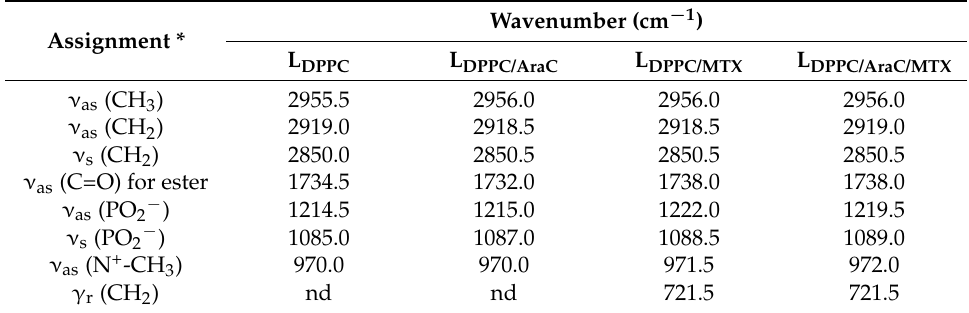
Table 2. Assigned bands of the FT-IR spectra of L DPPC , L DPPC/AraC , L DPPC/MTX , L DPPC/AraC/MTX liposomes.